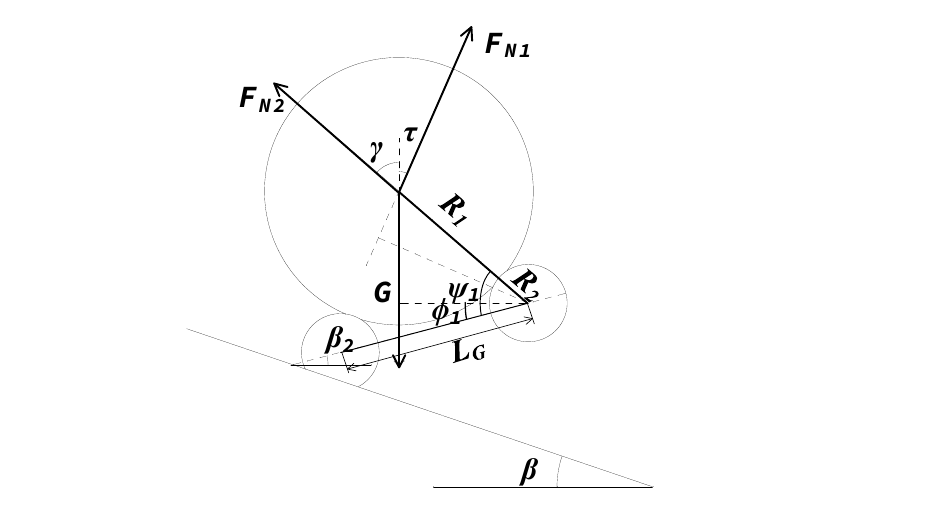
Figure 8. The stress diagram of jujubes on the conveying combination rod. β and β 2 is the installation angle of the conveying and separating device and the included angle between the conveying combination rod and the horizontal plane respectively, (°); R 1 and R 2 are the radius of jujube and the radius of conveying combination rod respectively, mm; L G is the distance between the centers of the two rods, mm; F N 1 and F N 2 are the support of the conveying combination rod to jujube respectively, N.